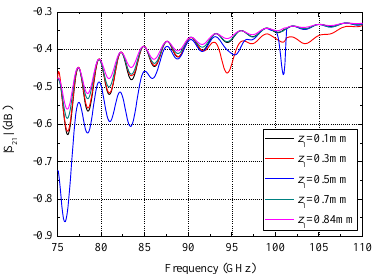
ff erent values of z 1